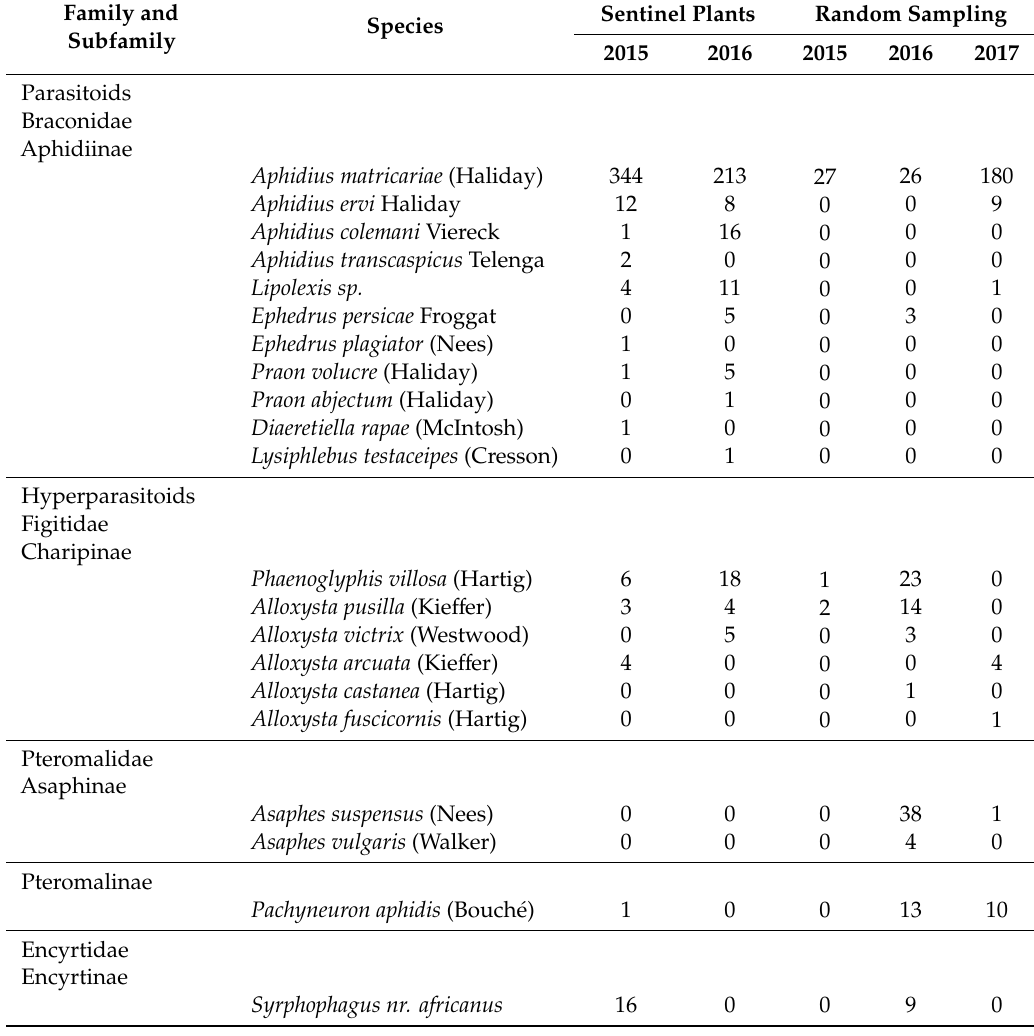
Table 2. Myzus persicae parasitoids and hyperparasitoids, collected on peach trees using both sampling methods during the 3-year